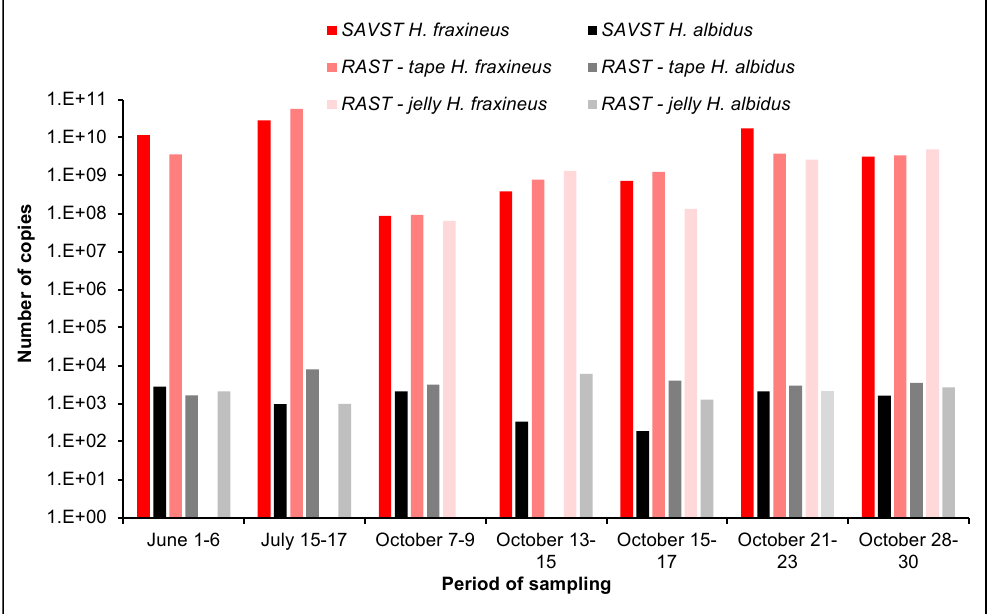
Figure 4. Comparison of different air samplers: SAVST = seven-day automatic volumetric spore trap; RAST-tape = rotating arm spore trap with double sided tape as the trapping medium; RAST-jelly = rotating arm spore trap with petroleum jelly as the trapping medium. Values are expressed as numbers of copies of the target sequence in 1 µL of template DNA in particular period of sampling in logarithmic scale.